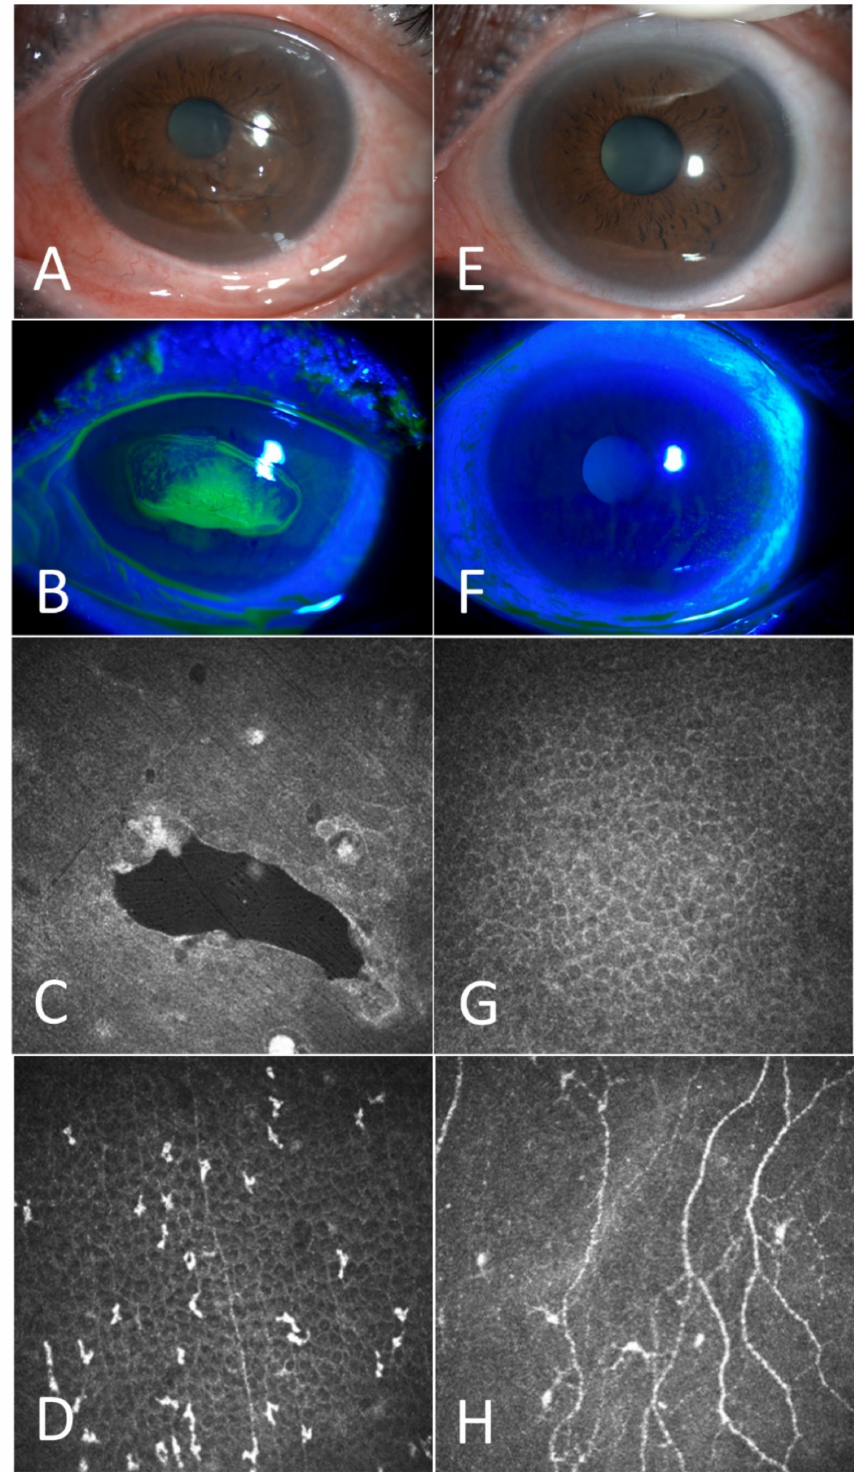
Figure 1. A case example before and 3 months after the coblation. Before the surgery: The corneal epithelium showed obvious detachment and corneal edema ( A ); Under cobalt blue light, fluorescein accumulates in the corneal loose area ( B ); Confocal microscopy revealed obvious cysts ( C ); corneal nerve reduction and increased activation of Langerhans cells ( D ). Three months after the surgery: Corneal edema decreased and corneal loose area disappeared ( E , F ); Confocal microscopy revealed that corneal epithelium became intact ( G ); bright reflective particles decreased and corneal nerves increased ( H